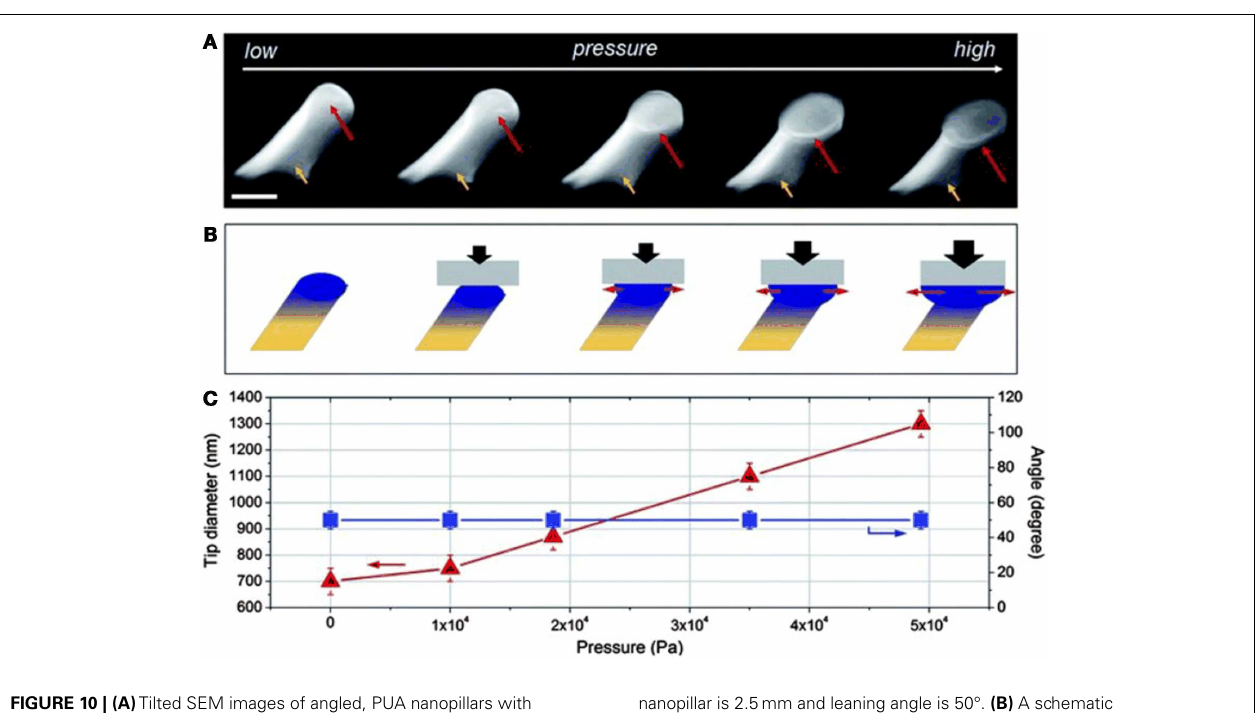
FIGURE 10 | (A) Tilted SEM images of angled, PUA nanopillars with different tip shapes from round to increasingly enlarged mushroom- like tips.The tip diameters of nanopillars increased with the increase of applied pressure.Tip diameters of nanopillars, from left to right, are 700, 750, 870, 1100, and 1300nm, respectively. Length of the